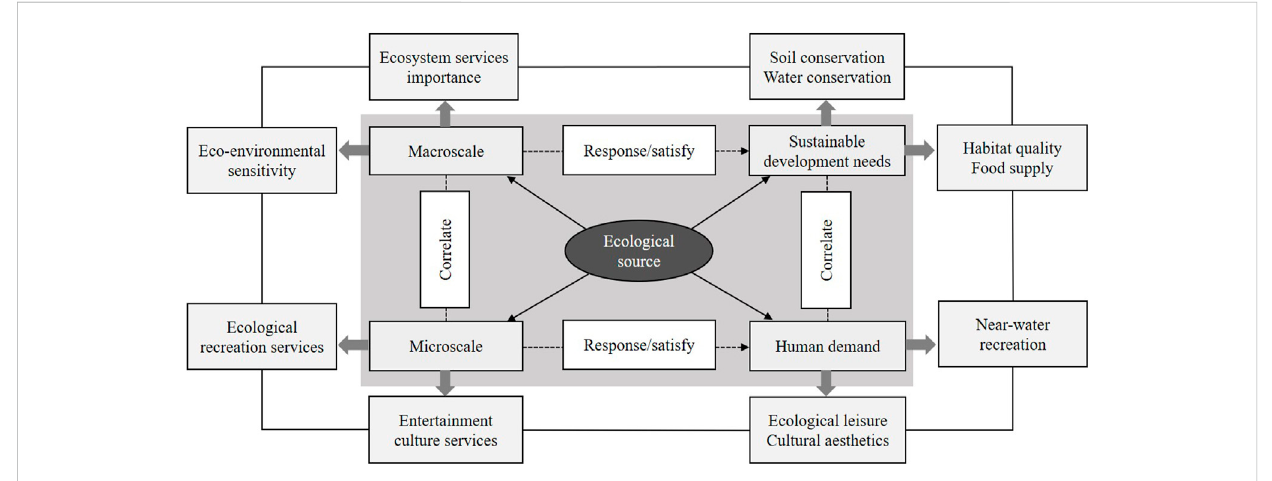
FIGURE 3 Identi fi cation of ecological sources based on scale perspective and hierarchical